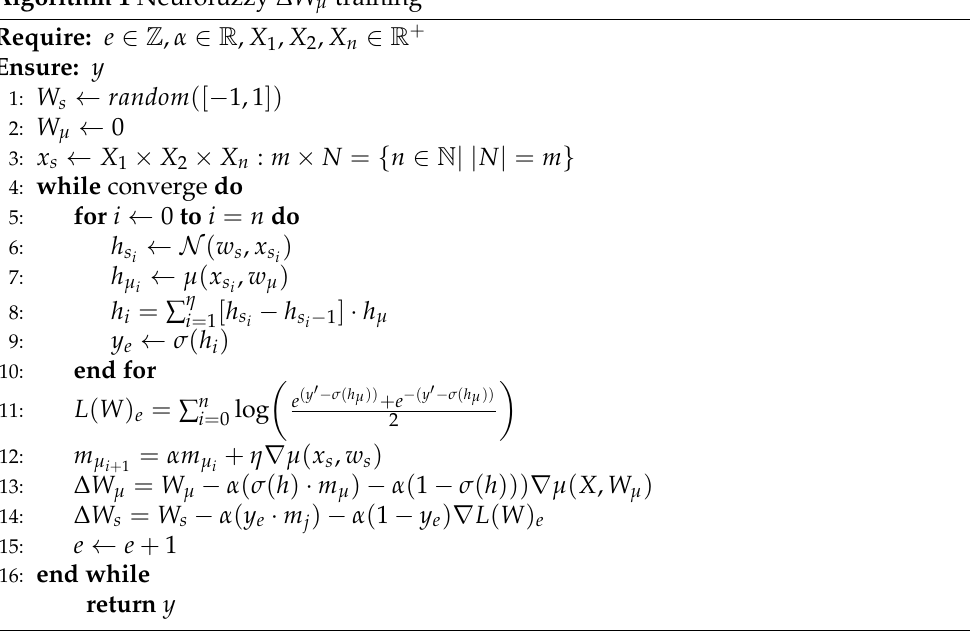
Algorithm 1 Neurofuzzy ∆ W µ training